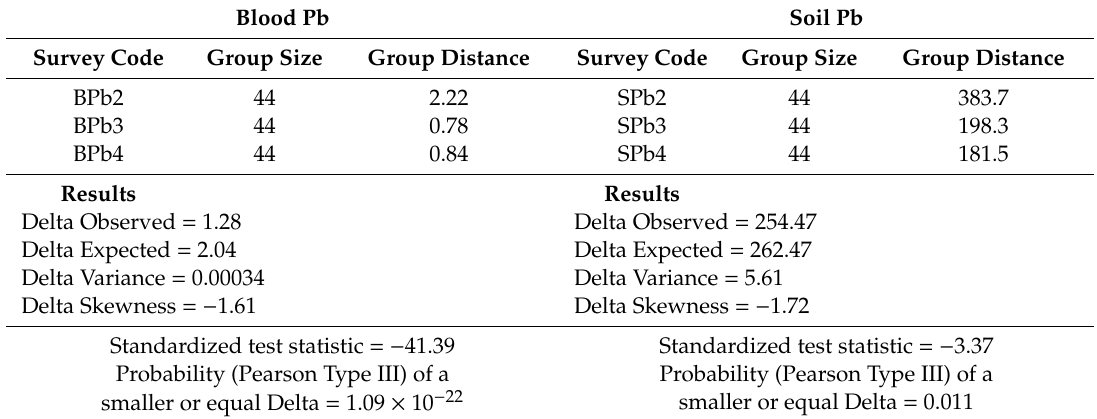
Table 2. Multi-Response Permutation Procedure Analysis of Blood Pb (left panel) and Soil Pb (right panel) results in 44 communities over three surveys. Notice that the extreme p -value of Blood Pb di ff erences indicating that the decline has been much larger than the decline observed for Soil